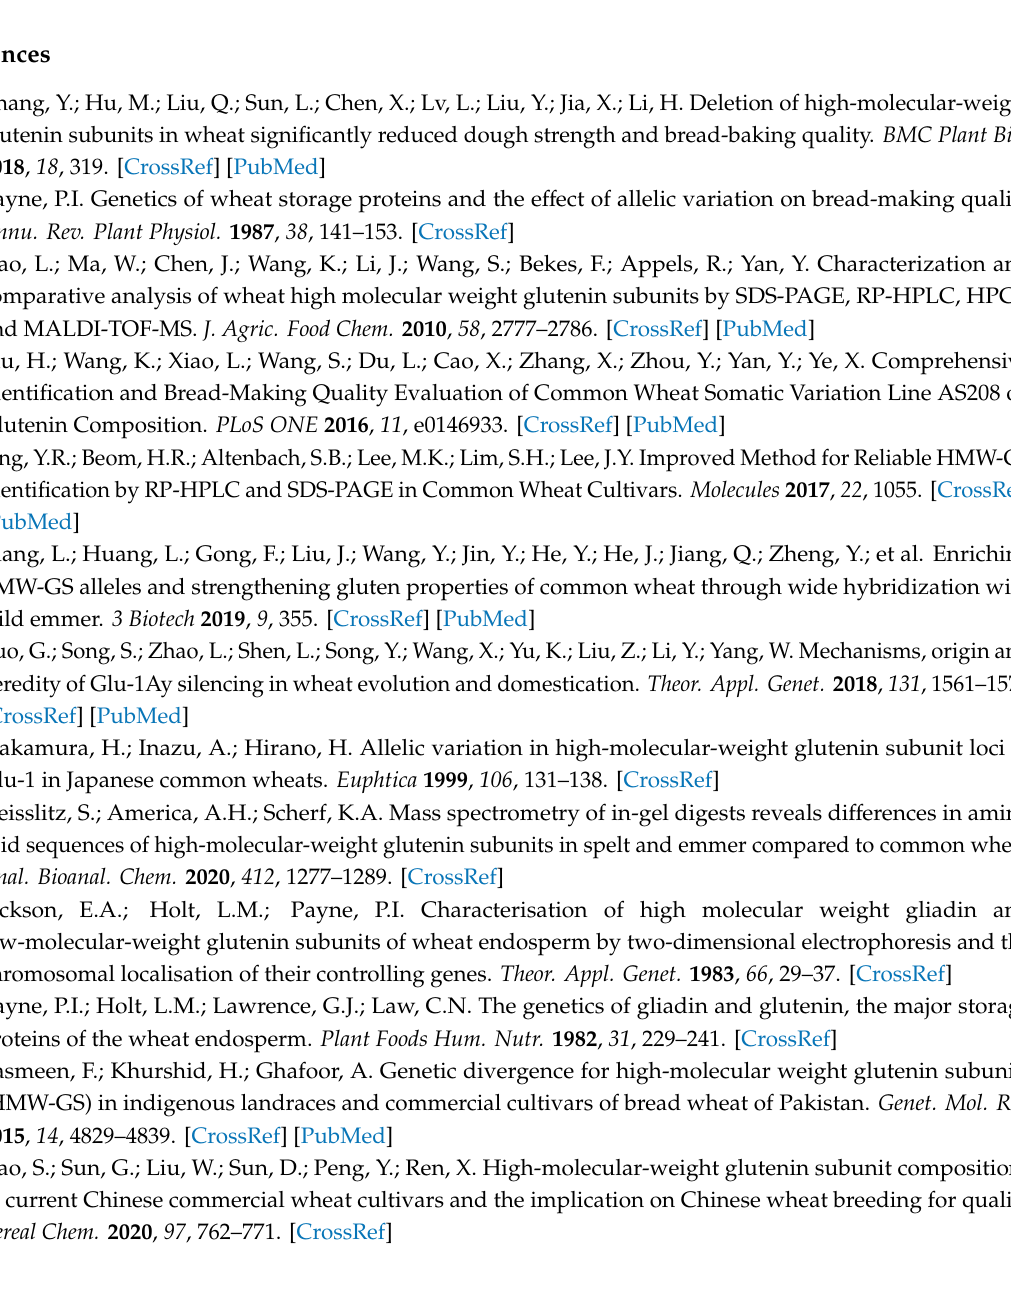
Figure S1: The electropherogram of the standard varieties on Lab-on-a-chip. Figure S2: Comparison of the electropherogram of the 7 OE subunit by Lab-on-a-chip. Table S1: Molecular weight and relative protein quantity of the standard varieties by Lab-on-a-chip. Table S2: Molecular weight of HMW-GS for 8 & 10 identification by Lab-on-a-chip. Table S3: Molecular weight of HMW-GS for 10 & 18 identification by Lab-on-a-chip. Table S4: Molecular weight and relative protein quantity of HMW-GS for 7 OE identification by